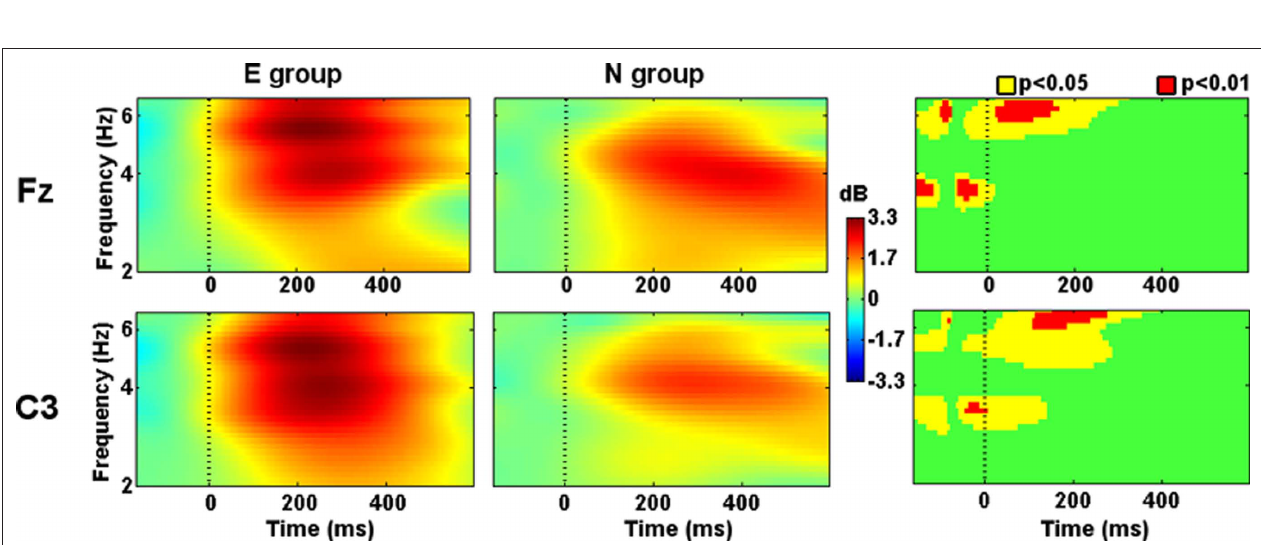
Figure 3 | evoked spectral perturbations in theta band. Activity recorded from Fz and C3 during Phase 2 stimuli presentation.